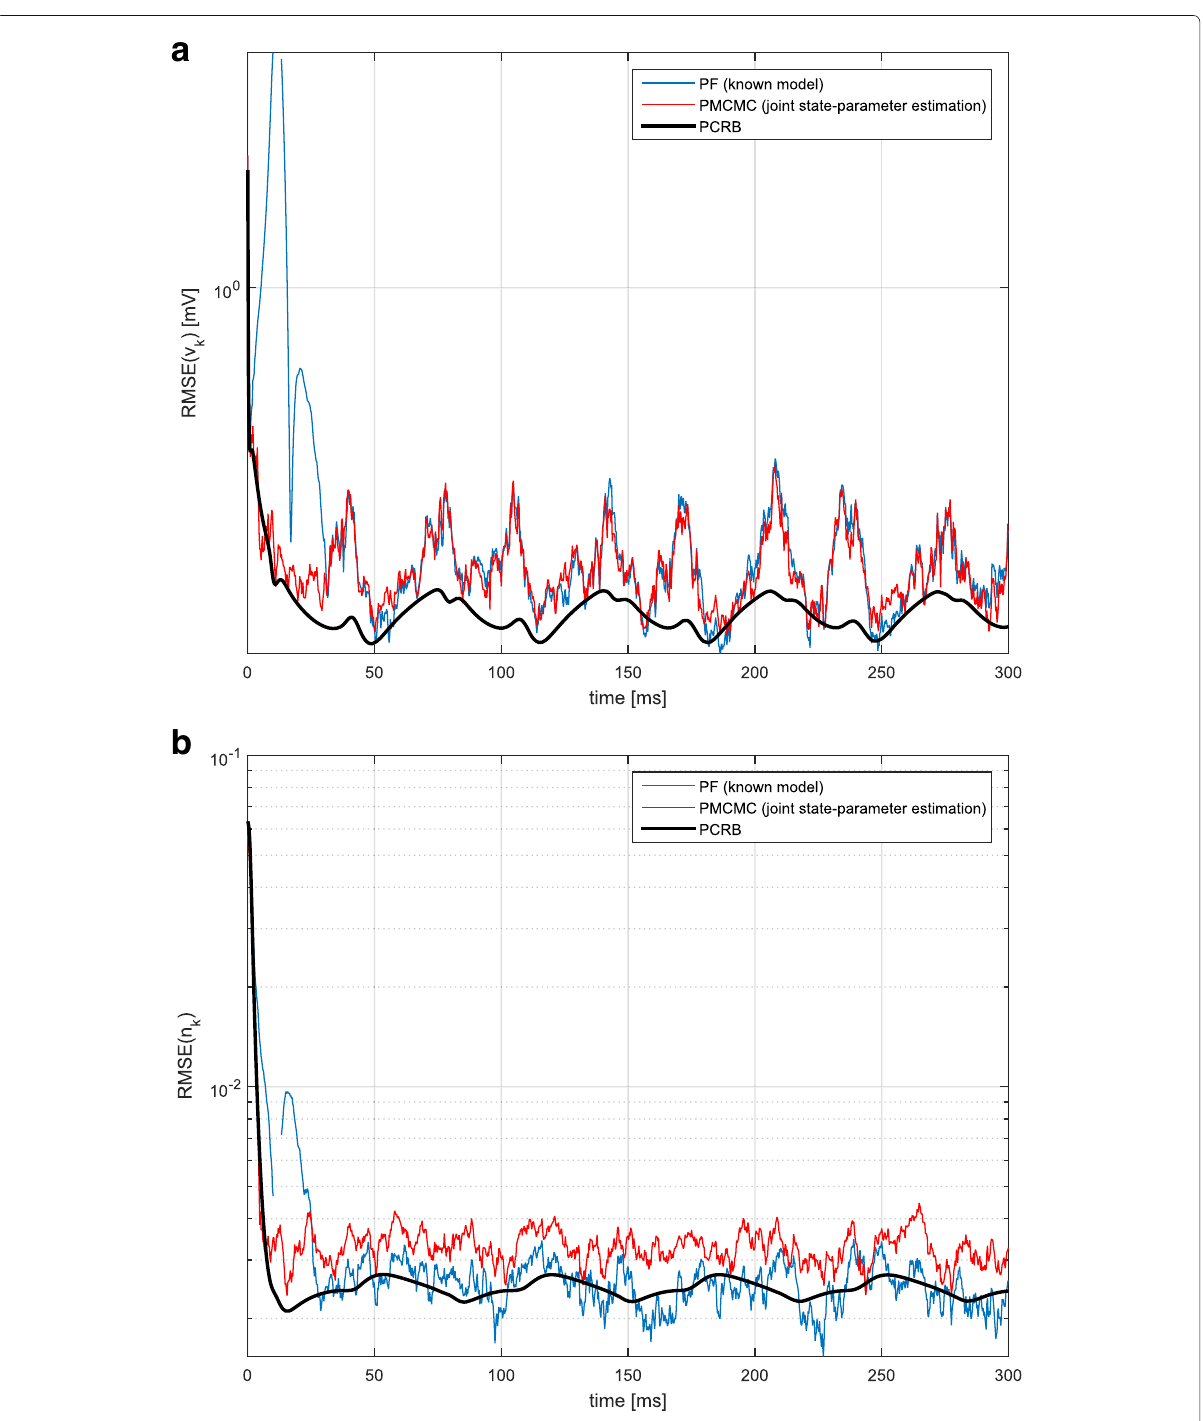
Fig. 6 Evolution of a RMSE( v k ) and b RMSE( n k ) over time for the PMCMC method estimating the leakage parameters. Model inaccuracies where = 0.1 · I σ = 0.1 · ¯ g o σ o and g L I